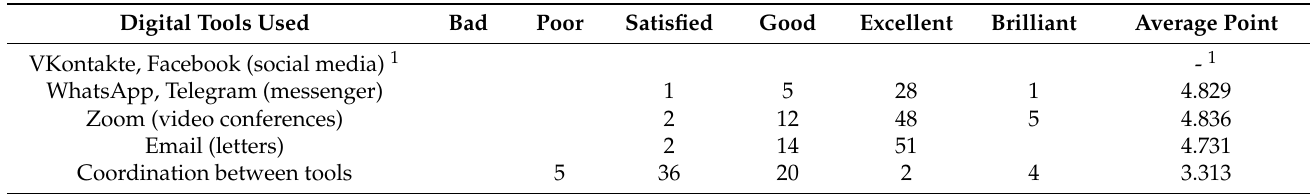
Table A8. Points awarded by students for digital tools applied in the framework of the traditional University pedagogy configuration, November 2020 (N4 =